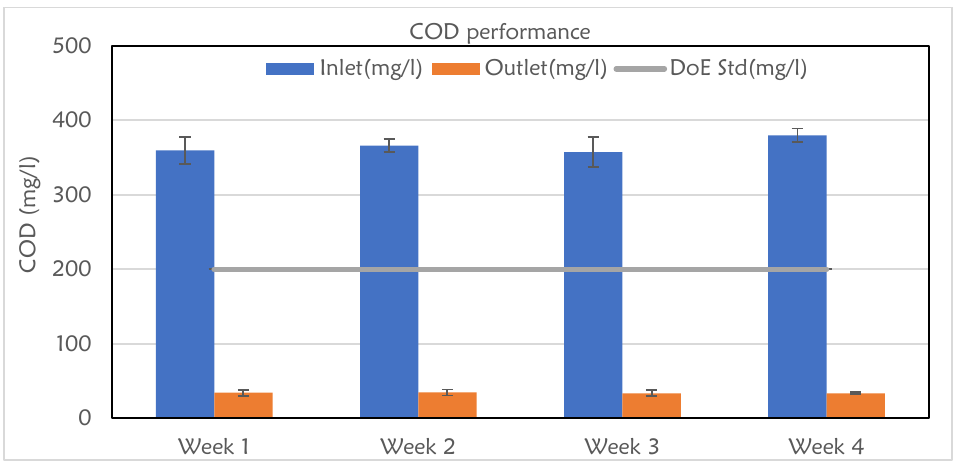
Figure 11: Percentage removal efficiency of COD analysis of 4 weeks.